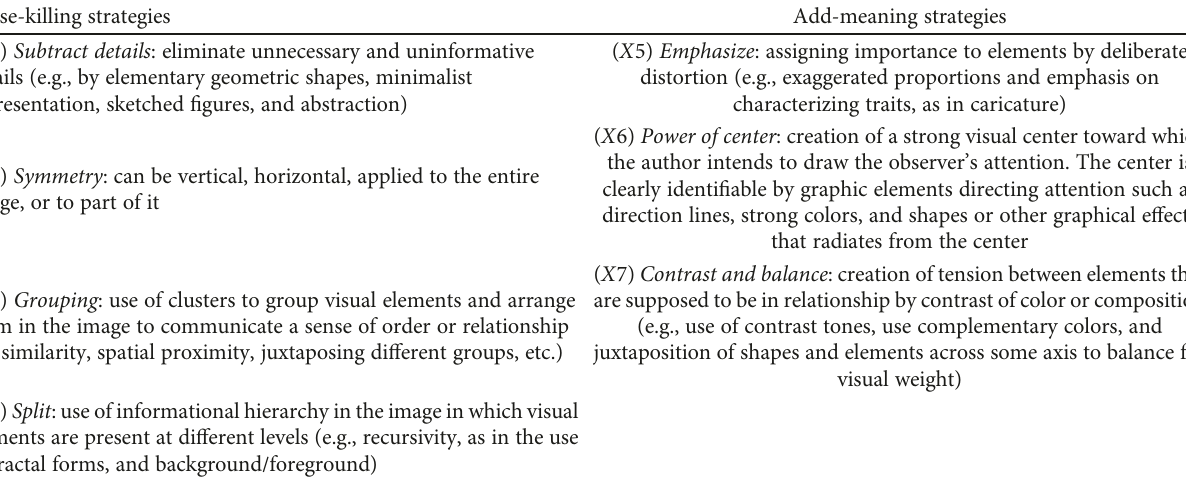
Table 1: Artistic strategies for reducing